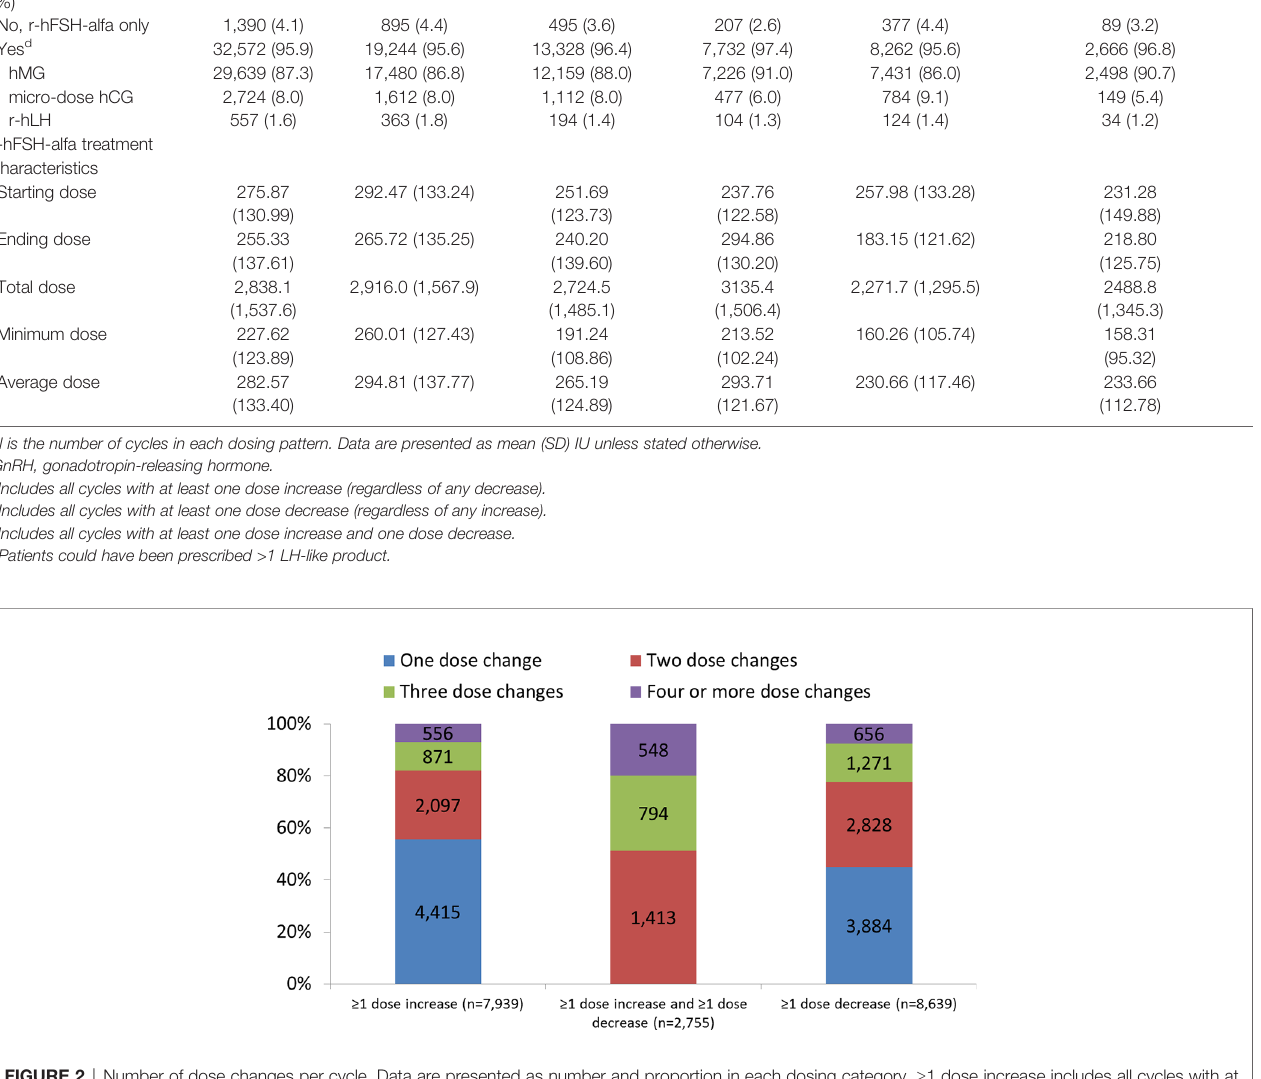
TABLE 2 | Dosing characteristics per cycle. GnRH use, n (%)